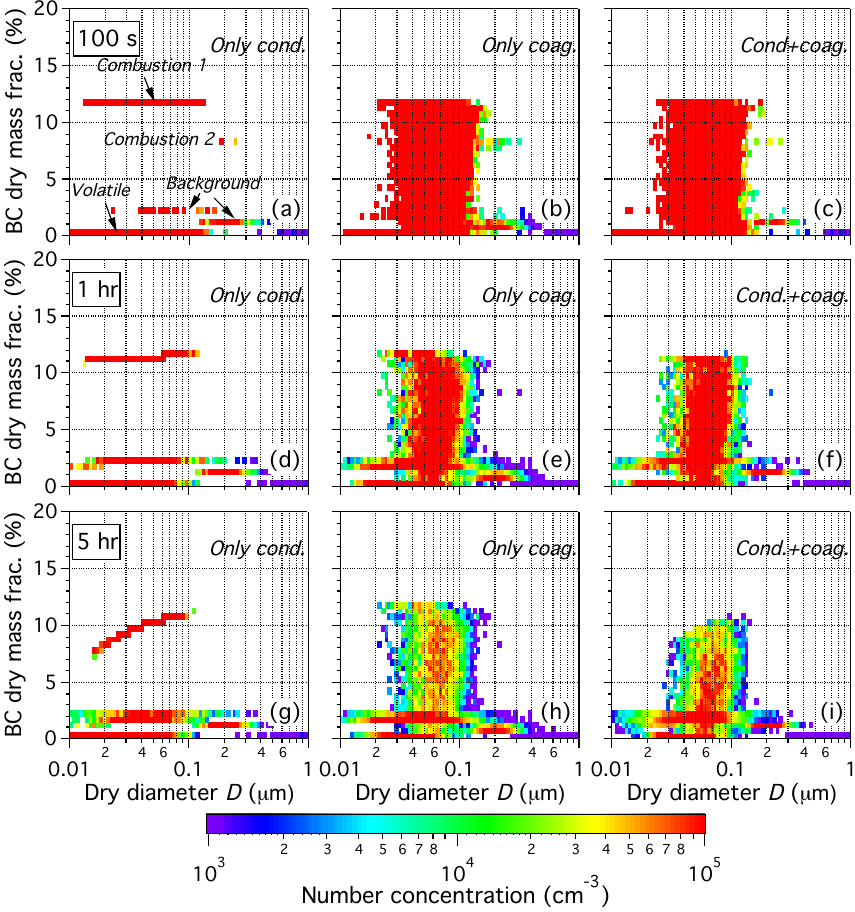
Figure 6. Two-dimensional number distributions n BC,dry (D, w) after 100s, 1h, and 5h of simulation for the base case. The two-dimensional number distribution is defined in Eq.